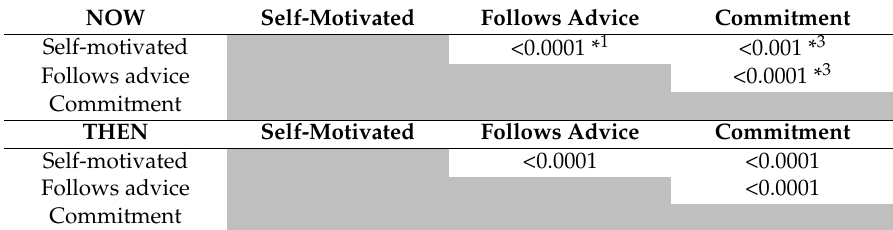
Table A15. Behavioural attitudes.